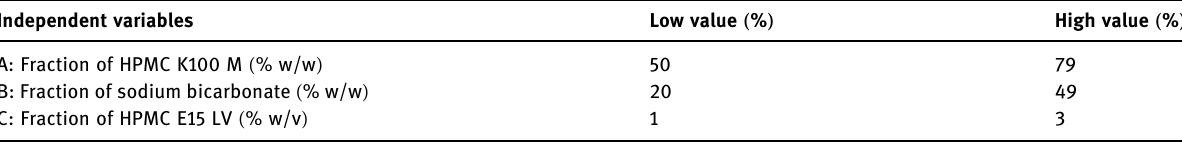
Table 1: Independent variables showing experimental ranges of the D - optimal mixture design Independent